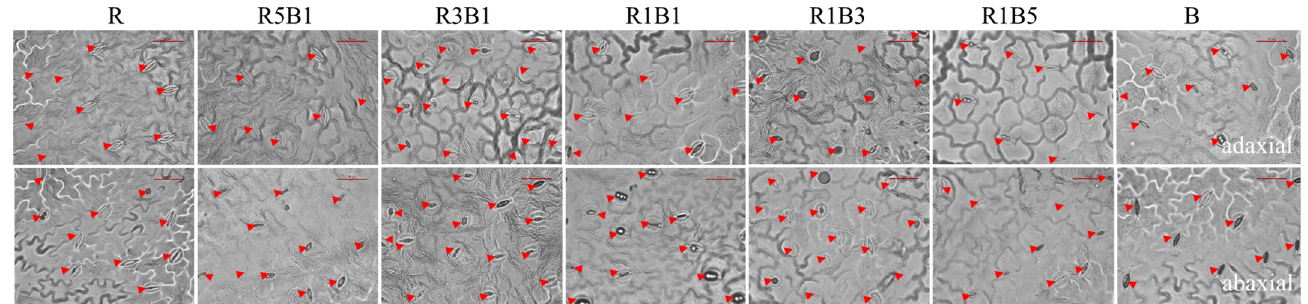
Figure 7. Schematic representation of the stomatal structure of the adaxial and abaxial sides of leaves under various R and B light ratios. The scale bar is 50 μ m. The red triangle indicates that location of the plant stomata . R: monochromatic red light; R1B5: red to blue ratio = 1:5; R1B3: red to blue ratio = 1:3; R1B1: red to blue ratio = 1:1; R1B3: red to blue ratio = 1:3; R1B5: red to blue ratio = 1:5; B: monochromatic blue